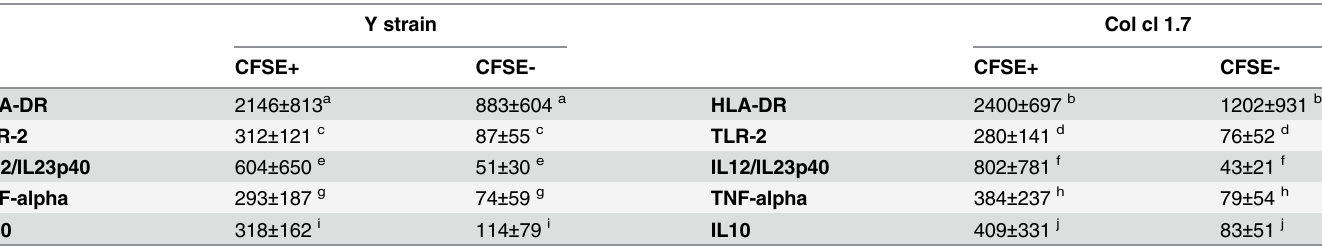
Table 1. Analysis of the mean intensity of expression of surface molecules and cytokines in monocytes CFSE+ and CFSE- after 15 hours of infec- tion with Y strain and Col cl1.7.